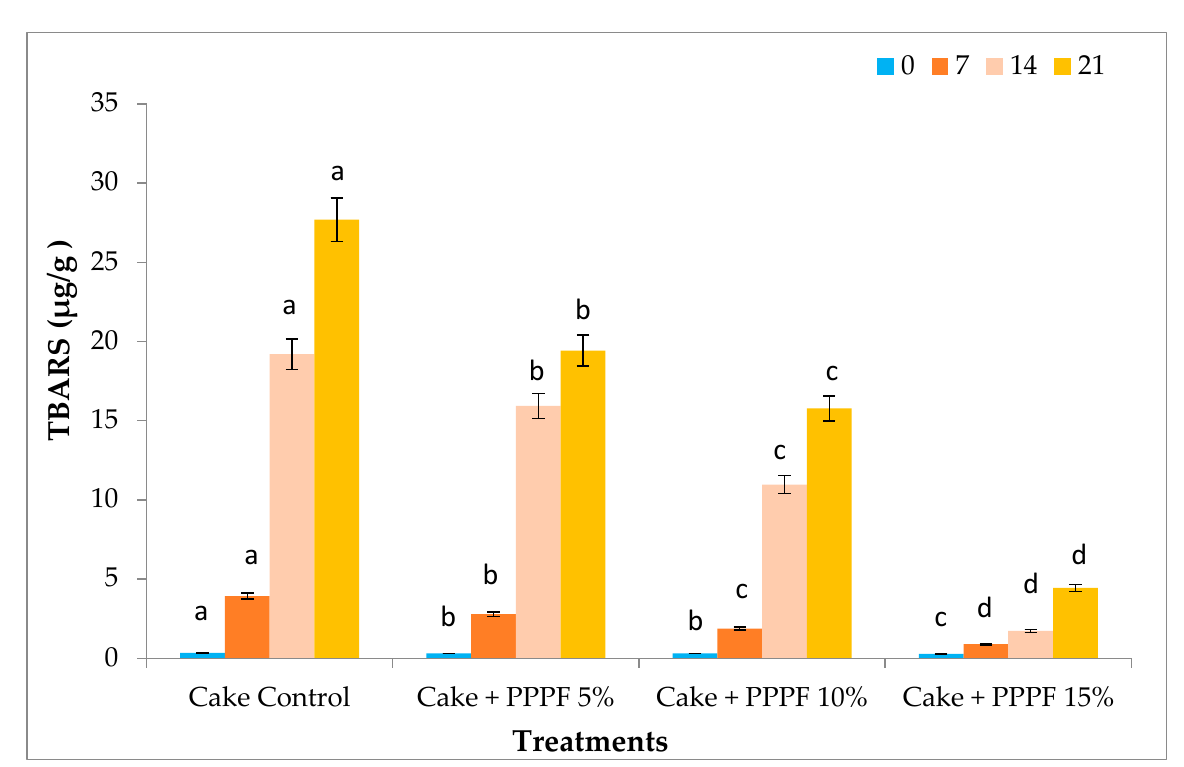
Figure 8. TBARS (µg/g) of cakes prepared by replacing flour with various levels of PPPF during storage (days). Each value represents the mean (±SD) of three different replications. The different letters on the same bar show a significant difference according to Duncan’s test at p ≤ 0.05.